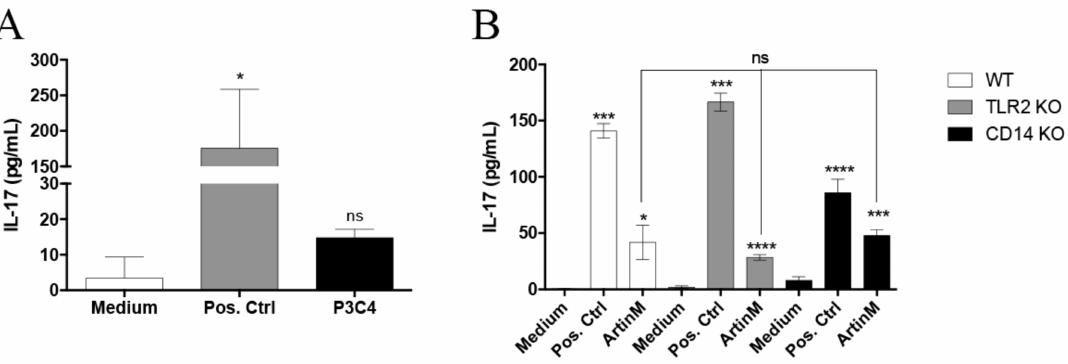
Figure 2. Effect of the absence of TLR2 or CD14 on IL-17 production induced by ArtinM in B cells. B cells (1 × 10 6 /mL) from wild-type (WT), TLR2 knockout (KO), and CD14 KO mice were stimulated with ArtinM (2.5 µ g/mL), P3C4 (1 µ g/mL), a positive control of stimulation (IL-6 (10 ng/mL); IL-1 β (10 ng/mL); IL-23 (10 ng/mL)), or medium alone (Medium) for 48 h at 37 ◦ C. ( A ) IL-17 production was measured using ELISA of the culture supernatant of B cells incubated with P3C4, the positive control of stimulation, or medium. ( B ) WT, TLR2 KO, and CD14 KO mice were used to obtain splenic B cells that were stimulated with ArtinM, the positive control, or medium. The culture supernatants were used for the measurement of IL-17 using ELISA, and the cells under stimuli were compared with the cells in the medium; the values were also compared between the WT and TLR2 KO or CD14 KO B cells stimulated with ArtinM. Data are shown as the mean ± SD; * p < 0.05, *** p < 0.001, **** p < 0.0001 and not significant (ns) were determined using the Kruskal–Wallis test, followed by the Dunn’s multiple comparison